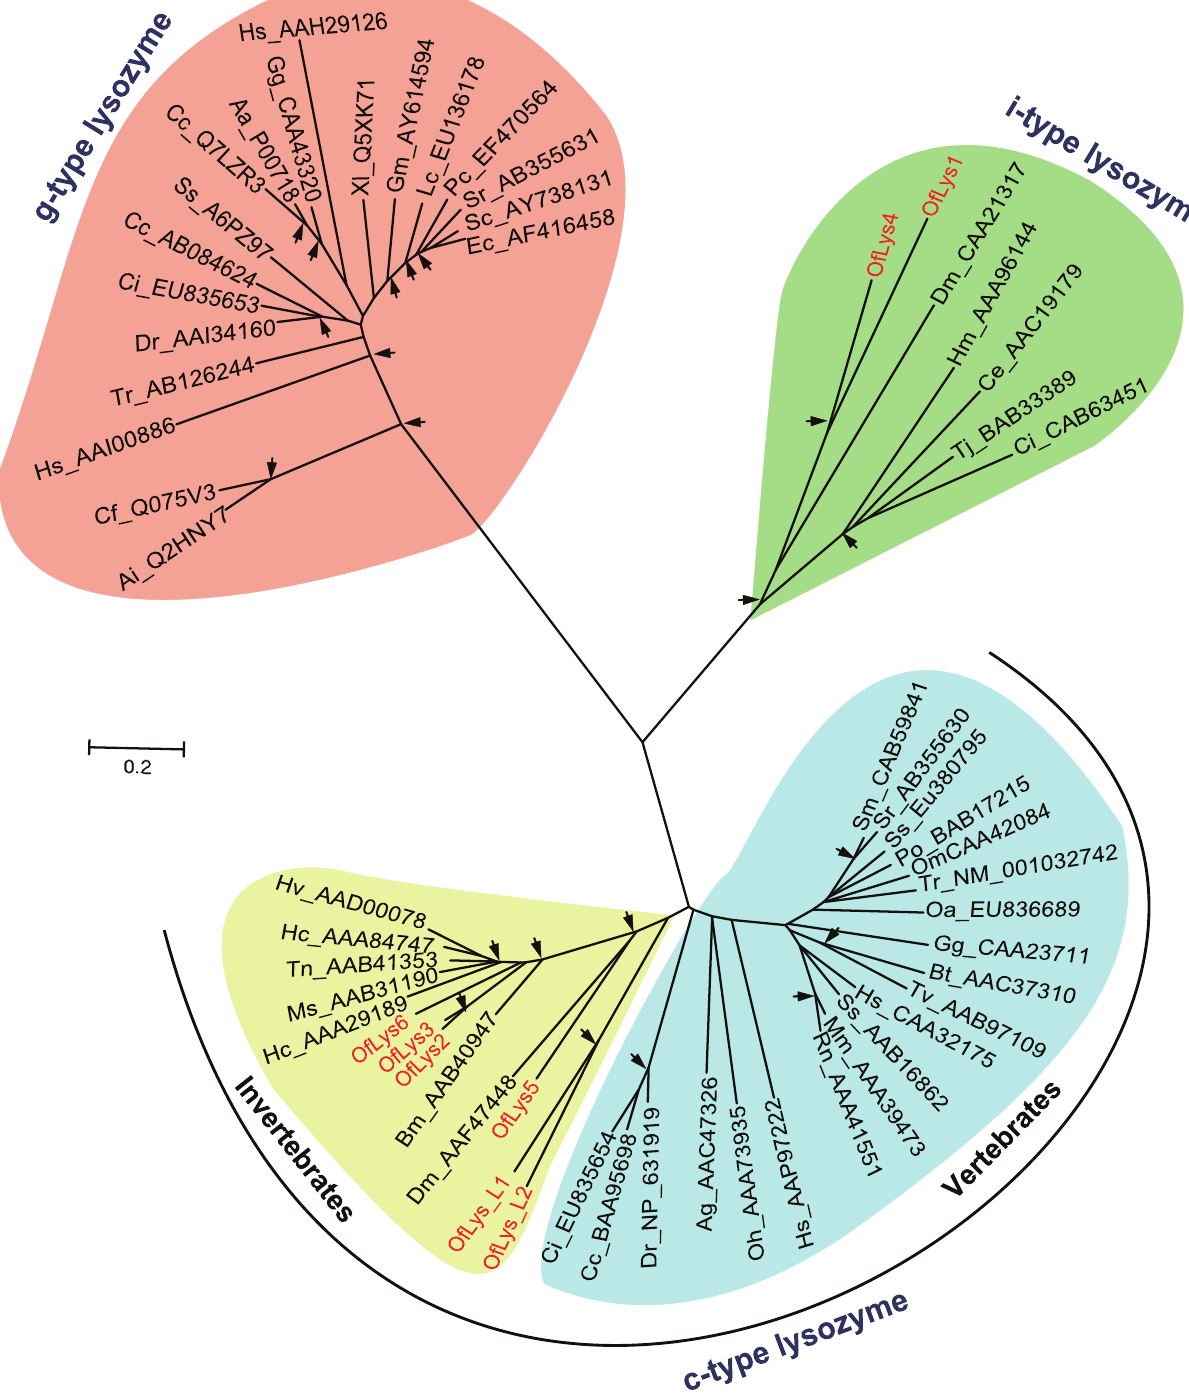
Figure 9. Phylogenetic analysis of lysozymes. The names of lysozyme genes used in the analysis were shown as scientific name of species followed by GenBank accession number of this specific gene. The Ostrinia lysozymes are marked in red. The branches specific for invertebrate c-type, vertebrate c-type, i-type, and g-type lysozymes are shaded in yellow, blue, green, and orange, respectively. For explanation of the arrows see Fig. 6. doi:10.1371/journal.pone.0086436.g009 lysozymes, cecropins, moricins, lebocins, gloverins, defensins, and groups: cecropins, insect defensins, lysozymes, proline-rich pro- teins, and glycine-rich proteins such as attacin [104,105]. Analysis attacins (Table 2). of the O. furnacalis transcriptome revealed a large number of Lysozymes catalyze the hydrolysis of the b -1,4-glycosidic bond unigenes with homology to the major families of AMPs such as between N-acetylglucosamine and N-acetylmuramic acids of